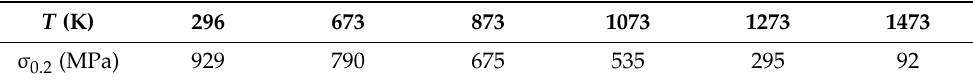
The strain rate: 10 − 3 s − 1